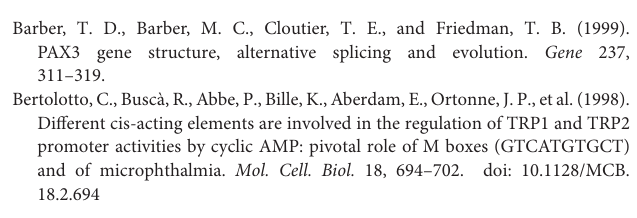
Supplementary Figure 1 | LR-PCR for the identification of the large deletion, PAX3 :c.959-409_1173+3402del. Supplementary Table 1 | Detailed information for quality control of WES